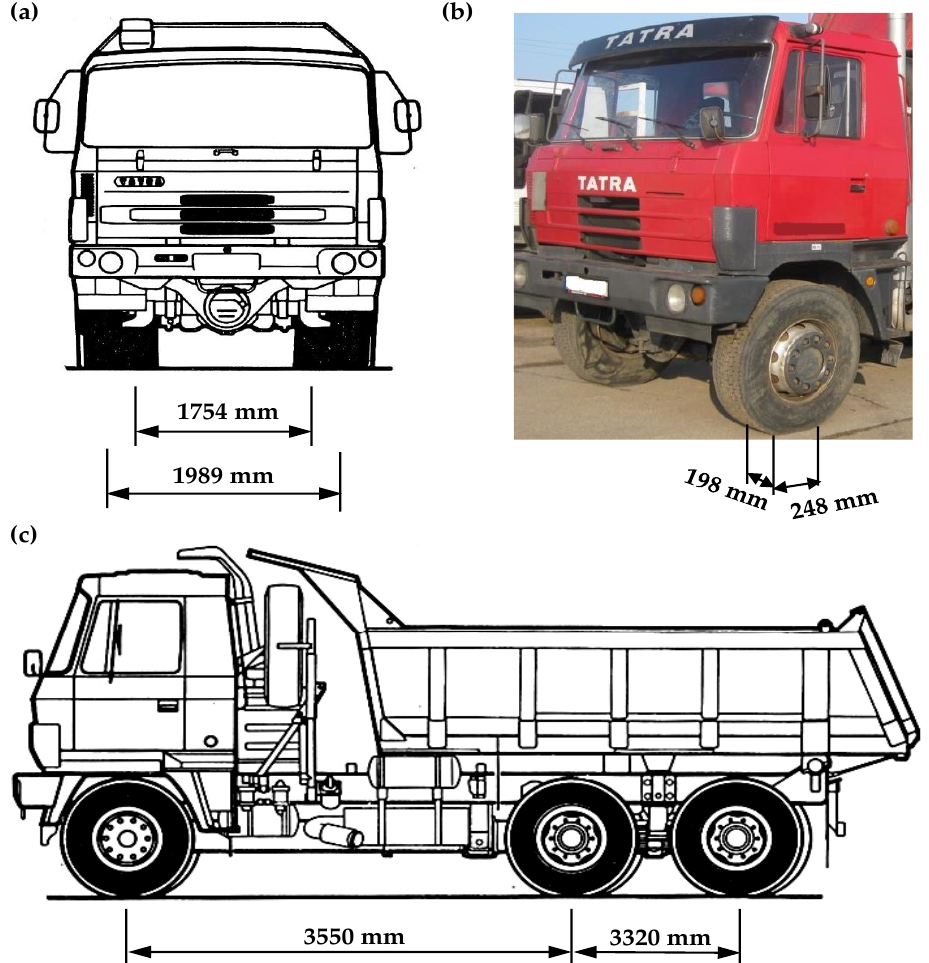
Figure 13. Real heavy truck-modeled load—TATRA T815-S3 26 208. ( a ) Front view with dimensions, ( b ) contact area, and ( c ) side view with dimensions. The figure was adapted from [54].